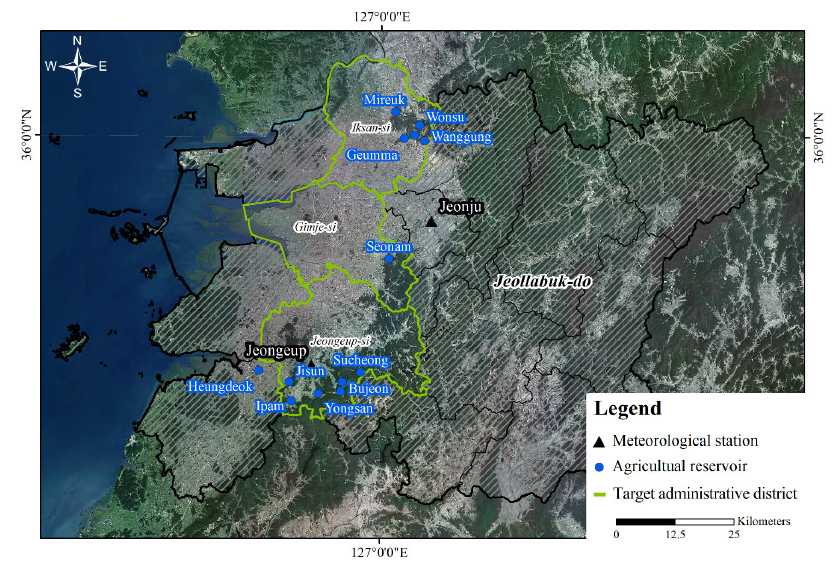
Figure 1. Distribution of 13 agricultural reservoirs and two meteorological stations.